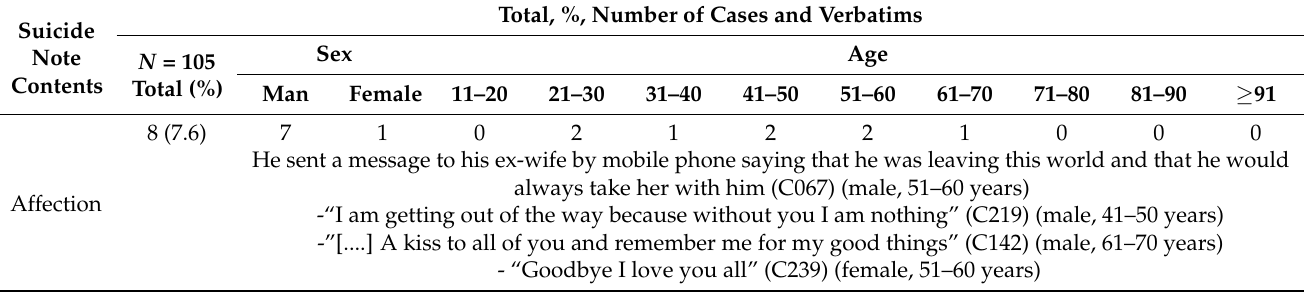
Table 5. Category: Suicide notes: content of suicide notes, percentage, number of male and female cases and age ranges, and associated verbatims of forensic